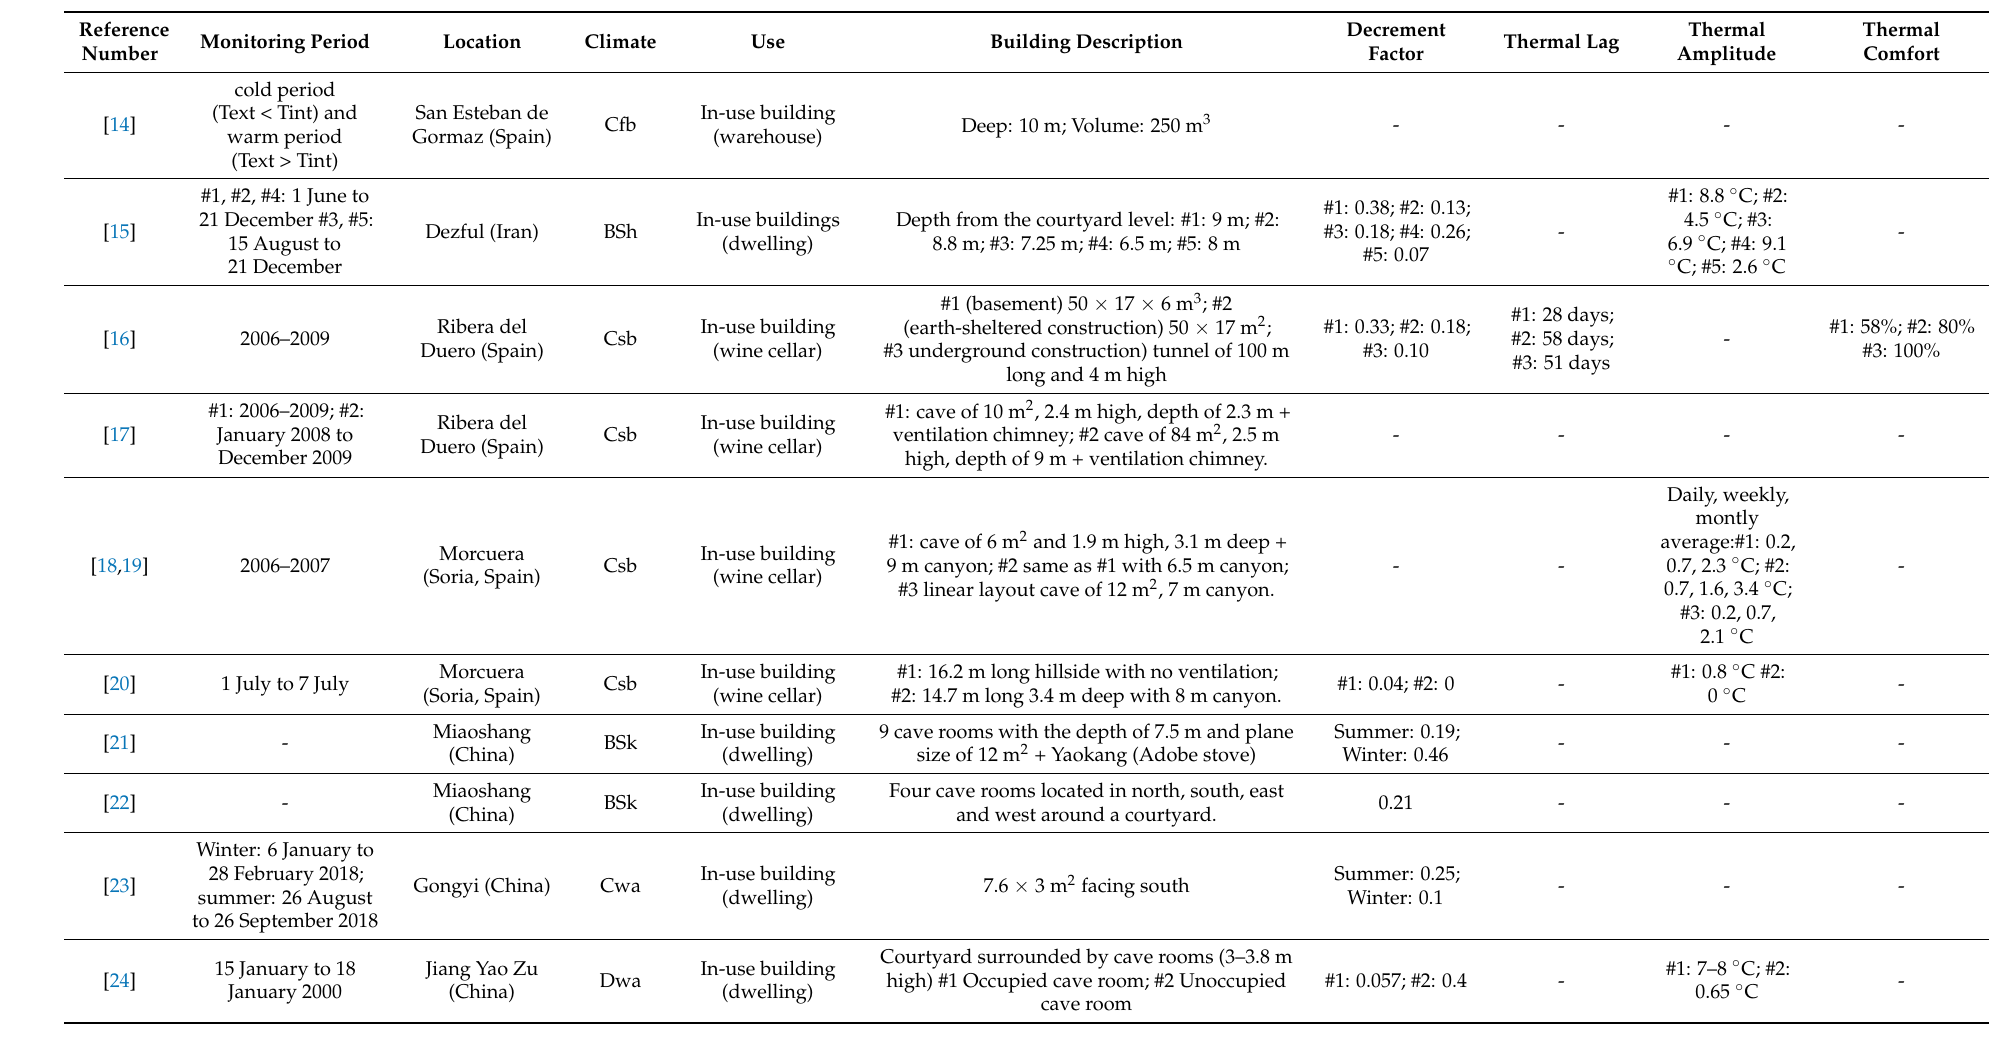
Table 2. Building characteristics and thermal performance of the dug out earth monitored